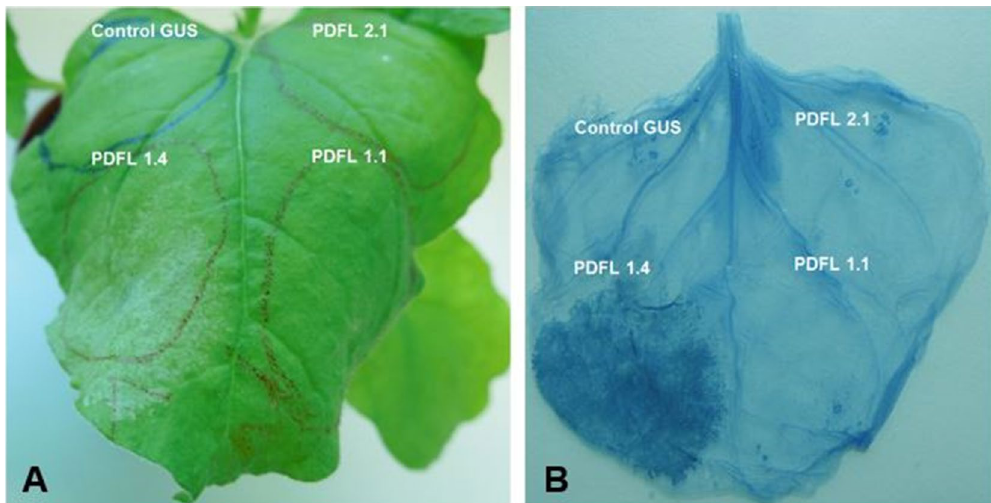
Figure 12. Transient expression of different PDFLs. Transient expression of PDFL 1.4 in N. benthamiana leaves results in strong HR in comparison to PDFL 2.1, PDFL 1.1 and control GUS. ( A ) HR starts to appear in the region that infiltrated with the PDFL 1.4 construct at 60 h after infiltration. ( B ) Cell-death is visualized with trypan blue staining.